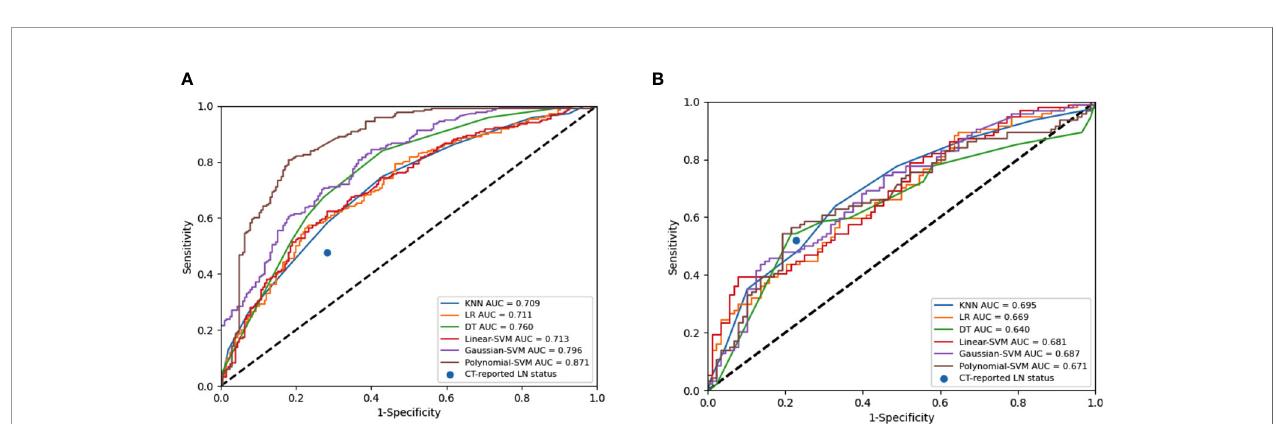
FIGURE 3 | Computed tomography (CT) image features selection using one-way analysis of variance (ANOVA) and the least absolute shrinkage and selection operator (LASSO) logistic regression model in the training set. (A) The fi ve-fold cross-validation and the minimal criteria process was used to generate the optimal penalization coef fi cient lambda ( l ) in the LASSO model. The vertical line de fi nes the optimal values of l , where the model provides its best fi t to the data. The optimal l value of 0.165 with -log ( l ) =1.5 was selected. (B) LASSO coef fi cient pro fi les of the radiomics features. The vertical line was drawn at the value selected using fi ve- fold cross-validation, where optimal l resulted in 14 nonzero coef fi cients.